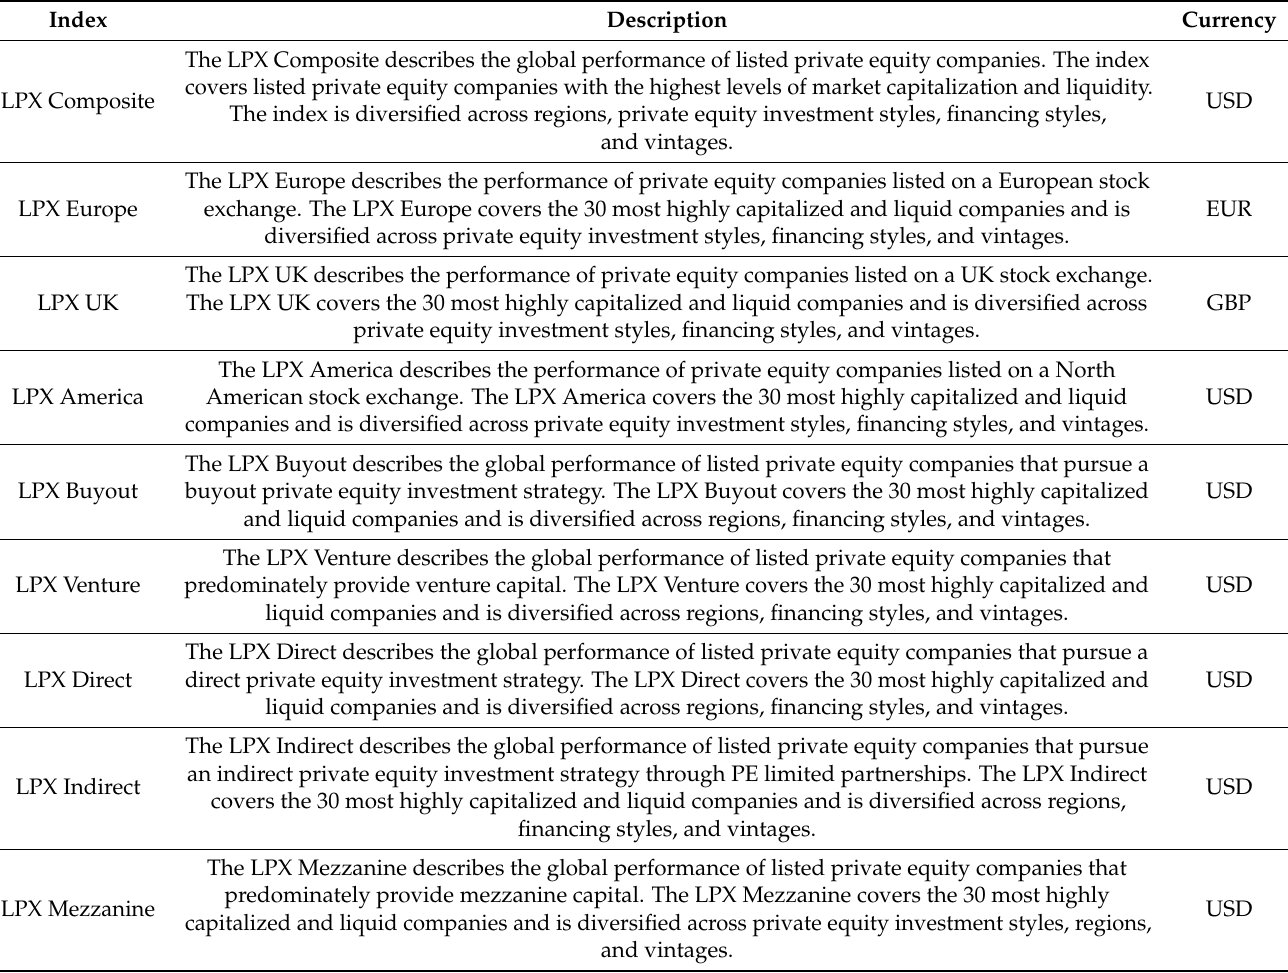
Table 1. Used LPX